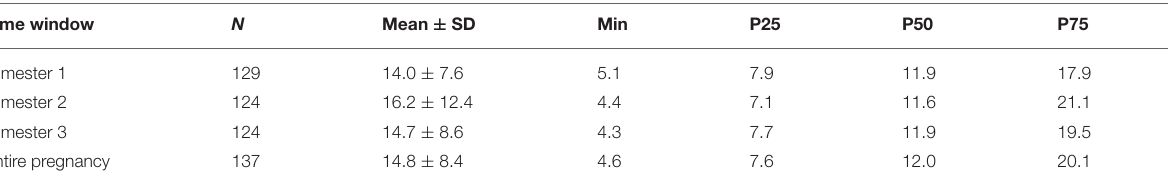
TABLE 2 | Descriptive statistics of prenatal NO x exposure ( µ g/m 3 ).